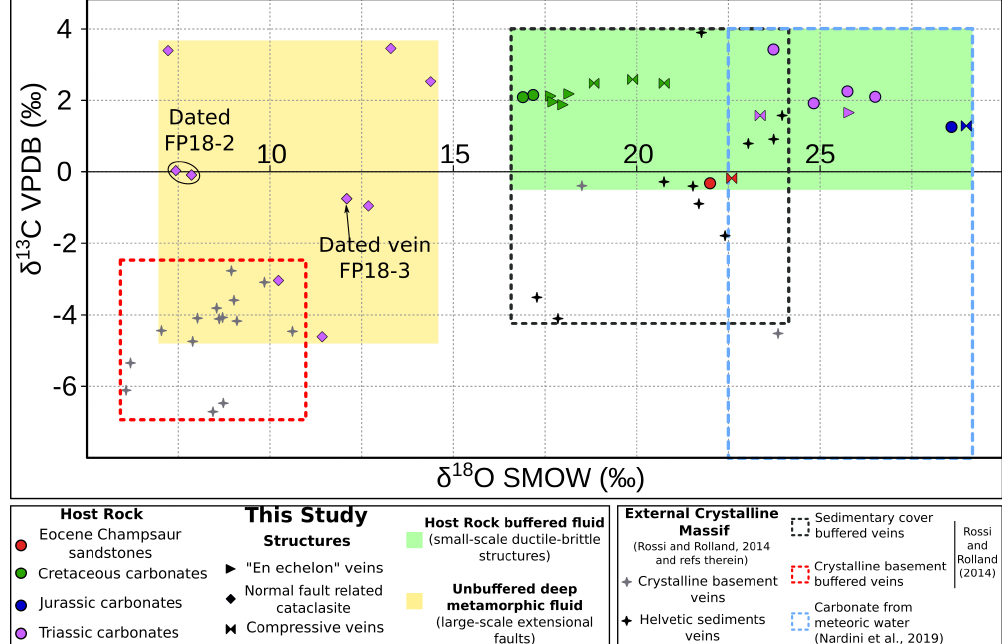
Figure 6. Stable isotopic data from samples indicated in Fig. 2. Domains represented by dashed red, black and blue lines are from the literature (Nardini et al., 2019; Rossi and Rolland, 2014, and references therein). The green domain corresponds to veins associated with brittle–ductile structures. These veins show similar isotopic compositions to their host rocks. The orange domain features the signature of cataclased normal fault samples, which show a different isotopic composition as compared to their host rock and are similar to deep metamorphic fluids (e.g. Crespo-Blanc et al., 1995; Rossi and Rolland, 2014; Rolland and Rossi,